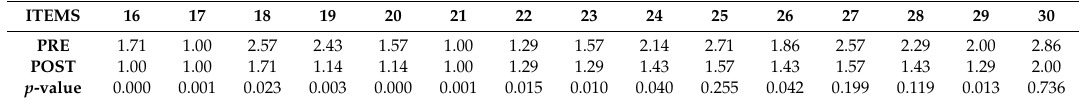
Table 2. DASH score of the mean value of items 15–30.